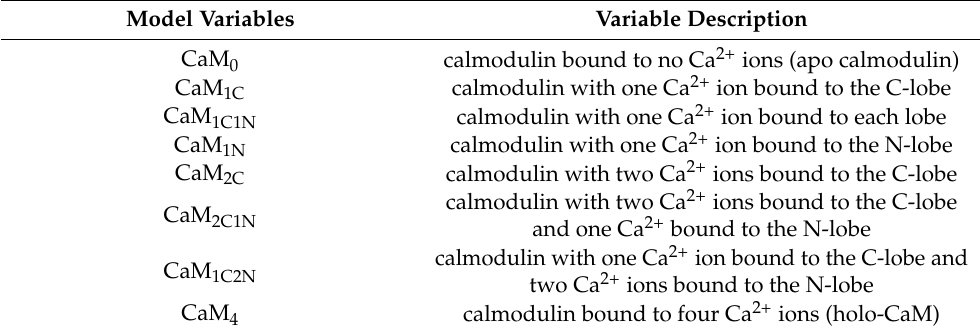
Figure 3. Pathway diagram representing reactions used in the mathematical model used in this paper. All arrows represent mass action reactions (all of which are reversible). Here, upon the binding activation by Ca 2+ , Holo-CaM can bind to and activate AC1/8, PDE1, PP2B subunits (i.e., CaNB and CaNA), and CaMKII. Upon binding to CaMKII, CaMKII can phosphorylate subunits of neighboring CaMKII subunits within a 12meric holoenzyme. The schematic diagram also includes complex regulation of PP1. PP1 is regulated by PKA and PP2B. This is because PKA and PP2B phosphorylate and dephosphorylate I-1, respectively. When I-1 is phosphorylated, it binds to and inhibits PP1. When I-1 is dephosphorylated by PP2B, it dissociates from PP1, and PP1 is active. PKA is activated by cAMP which, is in turn, controlled by ACs and PDEs. Upon activation by cAMP, as well as phosphorylating I-1, it can also phosphorylate PDE4B/D, which then represses cAMP, CaMKII, PP1, and PKAc; activates PP2B; then coordinates the phosphorylation sites of AMPAR. Phosphorylation of AMPAR can modulate its conductance and numbers anchored in the PSD. Table 1. CaM states in the